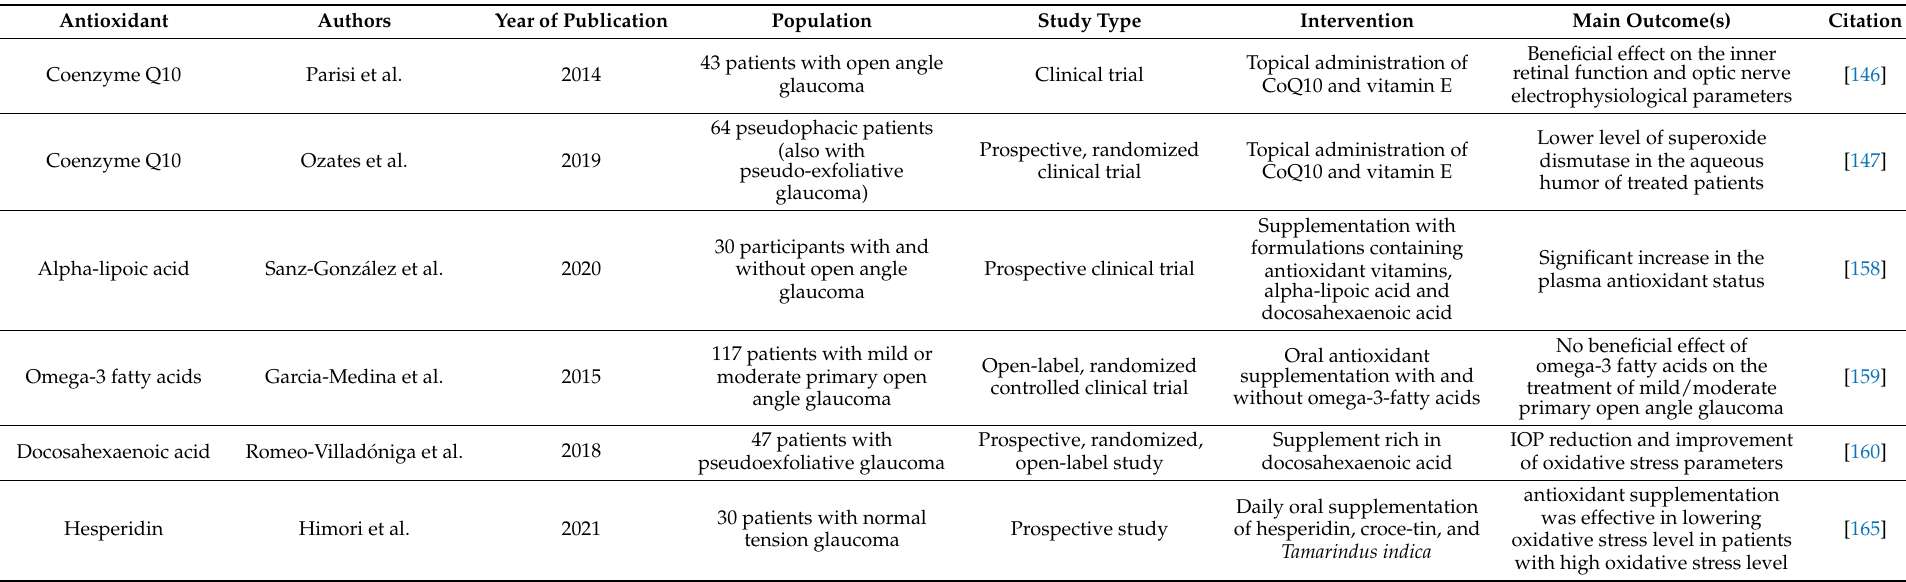
Table 2. The effects of antioxidant supplementation and therapies on glaucoma in clinical trials/case